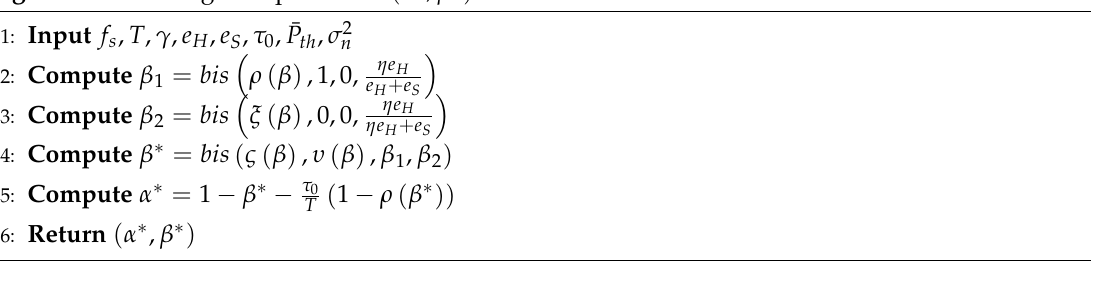
Algorithm 1 Finding the optimal set ( α ∗ , β ∗ )